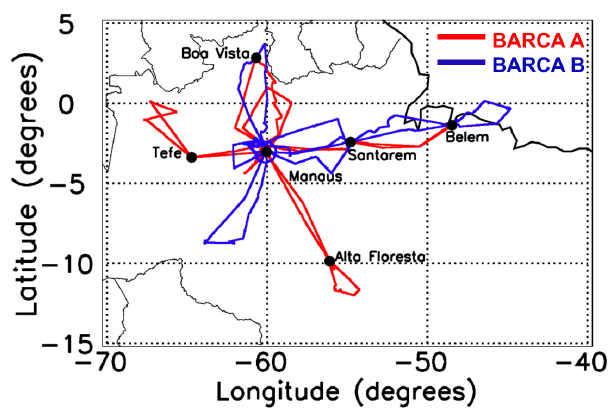
Figure 1. Flight tracks during